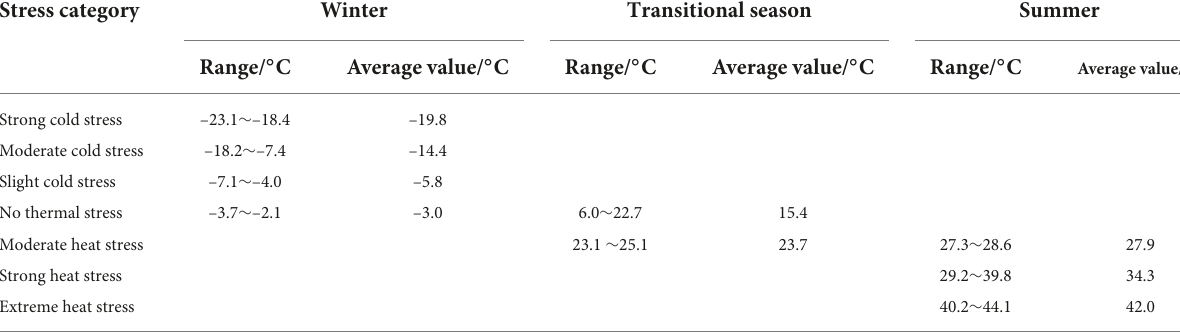
TABLE 3 Sample classification according to the universal thermal climate index (UTCI) thermal stress interval.